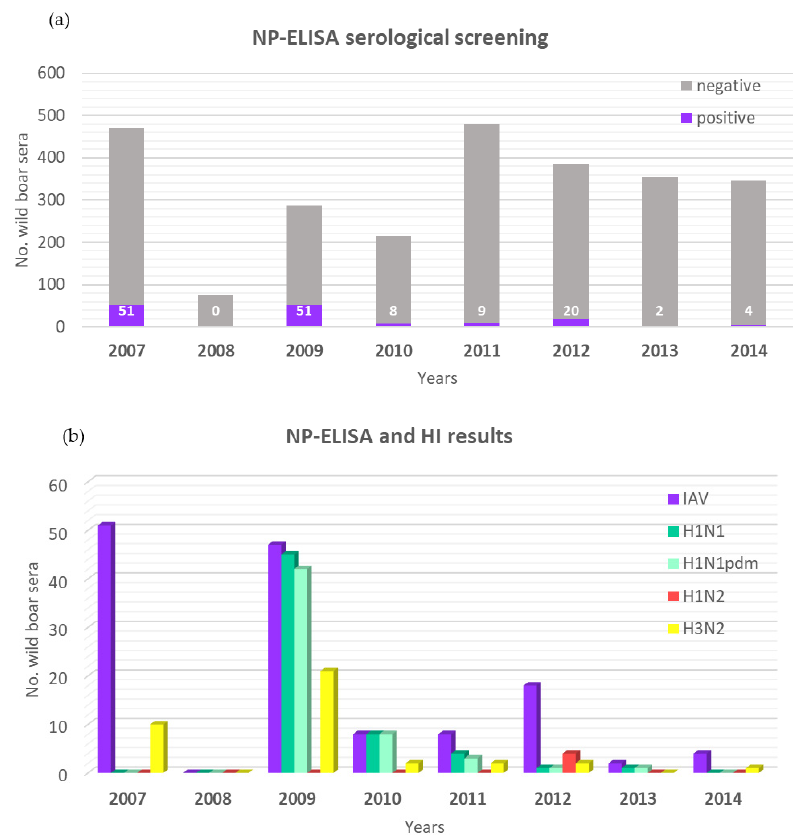
Figure 2. Serological evidence of influenza A virus (IAV) exposure in wild boars ( Sus scrofa ) from an anthropized area of Northern Italy (2007–2014): ( a ) Wild boars screened for the presence of anti-influenza A nucleoprotein (NP) antibodies by NP-ELISA. ( b ) NP-ELISA-positive wild boars examined by HI assay against sIAV subtypes representative of viruses circulating in Italian pig farms. Recaptured wild boars are not included in this figure. See Table 2 for details about the seven sIAV strains